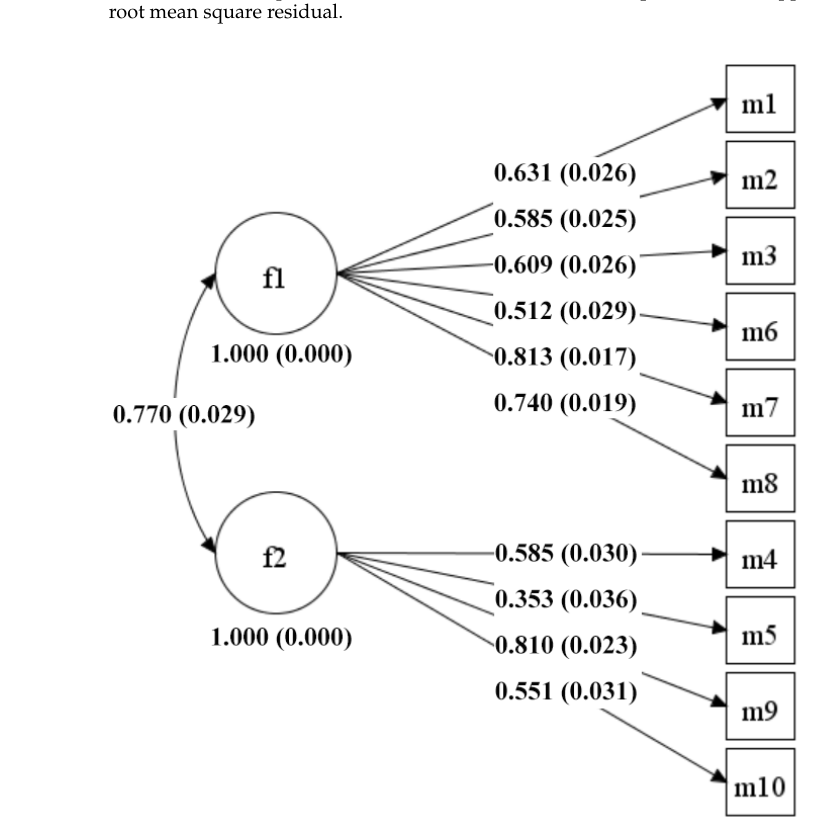
Figure 1. Diagrams of the two-factor CFA standardized model of the Chinese version of the CAMM for primary school students ( n = 1283). f1 and f2 are the two factors of the Chinese version of the CAMM; m1 − m10 are items 1 − 10.